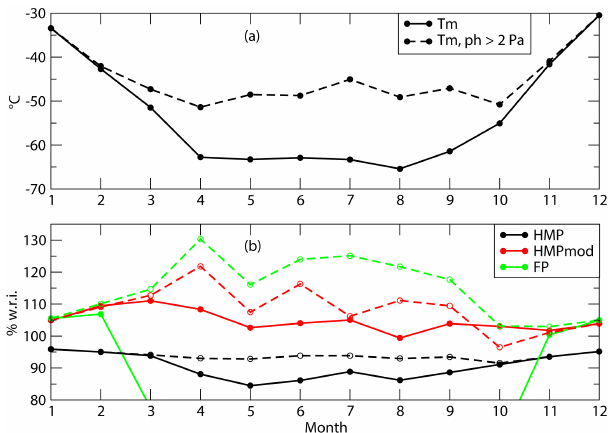
Figure 8. Seasonal variability of monthly-mean temperature T m (a) and RH i (b) for all reports (solid lines) and reports with moisture partial pressure ph above 2Pa only (dashed lines). With all reports, the curve for FP reaches below 30%, well beyond the plot scale (green solid line).